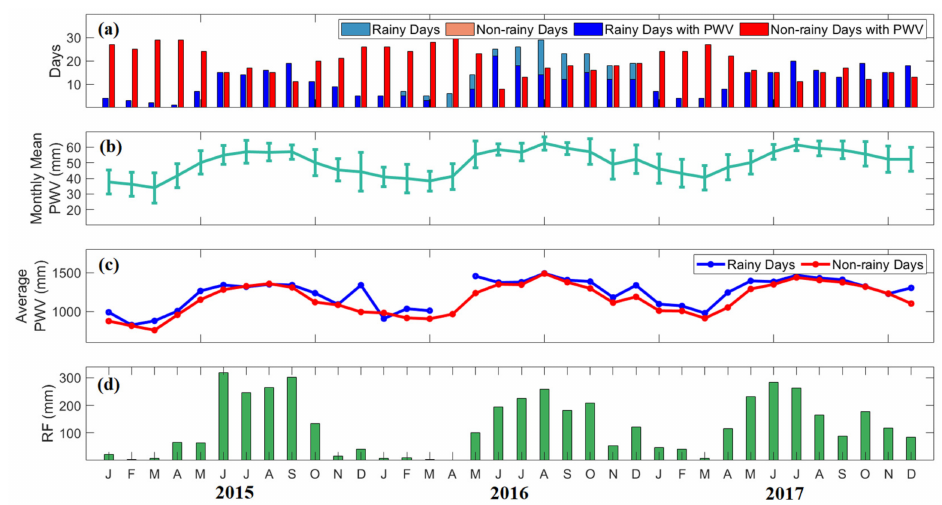
Figure 6. ( a ) The number of rainy days (light blue) and non-rainy days (pink) and rainy (blue) and non-rainy days (red) with PWV per month in Quezon City from 2015 to 2017. ( b ) The monthly mean variations of PWV for all days, ( c ) monthly average of daily PWV and ( d ) monthly rainfall are also presented. Blue lines correspond to average PWV on rainy days and red lines are for average PWV in non-rainy